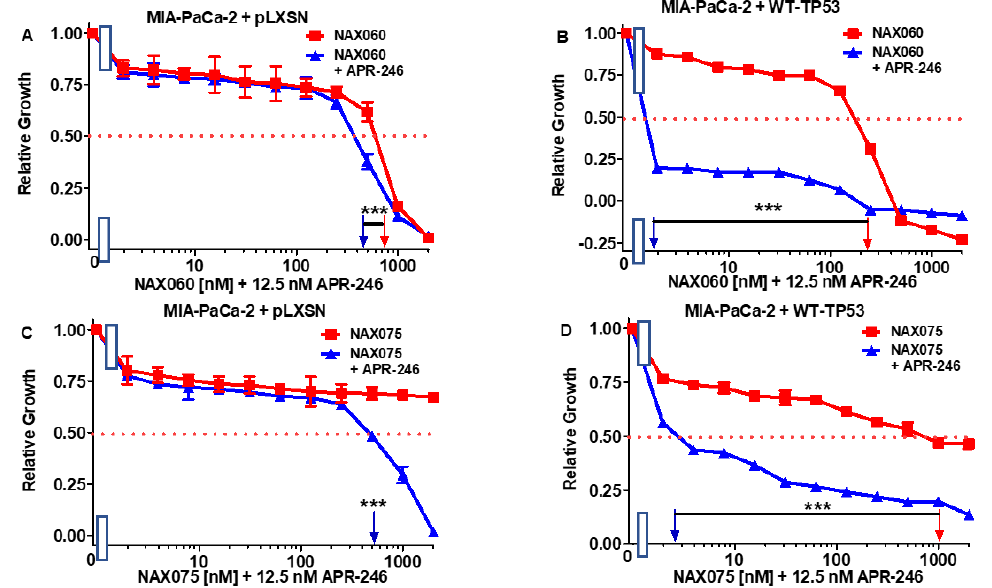
Figure 7. APR-246 is more effective in enhancing the effects of NAX060 and NAX075 in MIA-PaCa-2 cell when WT-TP53 is present. Panel ( A ) MIA-PaCa-2 + pLXSN cells treated with different concentrations of NAX060 (red squares) or with different concentrations of NAX060 and a low dose of APR-246 (blue triangles). Panel ( B ) MIA-PaCa-2 + WT-TP53 cells treated with different concentrations of NAX060 (red squares) or with different concentrations of NAX060 and a low dose of APR-246 (blue triangles). Panel ( C ) MIA-PaCa-2 + pLXSN cells treated with different concentration of NAX075 (red squares) or with different concentrations of NAX075 and a low dose of APR-246 (blue triangles). Panel ( D ) MI-PaCa-2 + WT-TP53 cells treated with different concentrations of NAX075 (red squares) or with different concentrations of NAX075 and a low dose of APR-246 (blue triangles). The measurements were repeated 4 times, and similar results were observed. *** = p < 0.0001.